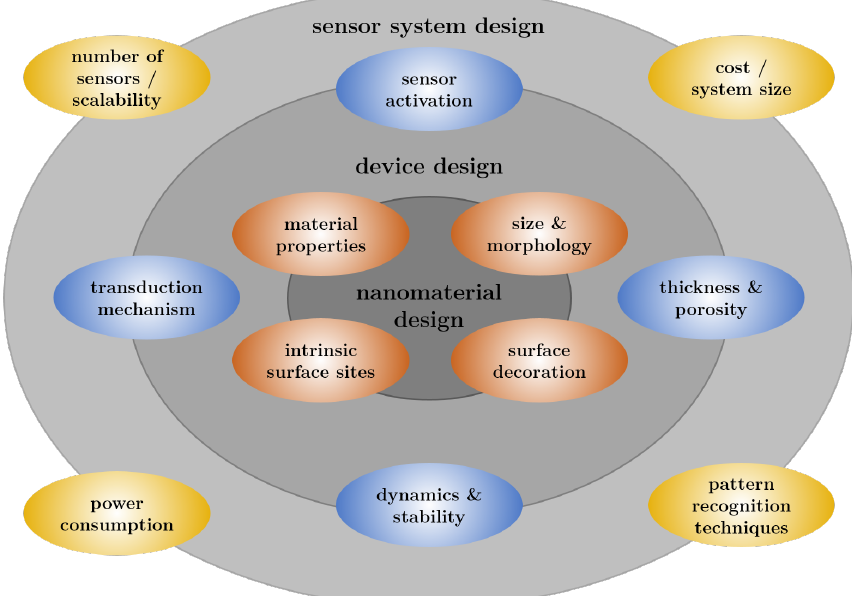
Figure 1. Schematic illustration of general factors influencing gas sensor properties, which need to be addressed by nanomaterial, device and sensor system design. This contribution aims at reviewing the respective aspects for copper oxide-based gas sensors reported in